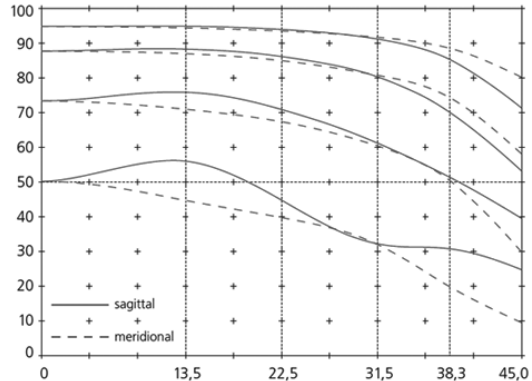
Figure 3. MTF of Rodenstock HR Digaron-W 50mm f/4 lens for aperture 5.6. The curves represent the 80, 40, 20 and 10 lp/mm frequencies. Source: (Rodenstock,